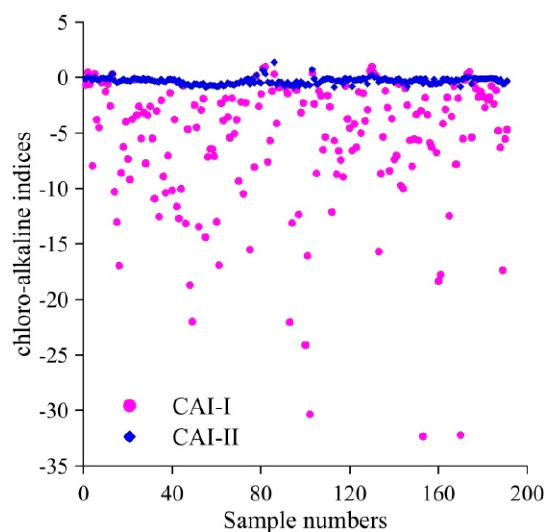
Figure 4. Scatter diagram of the chloro-alkaline indices (CAI-I and CAI-II) of groundwater samples in the study region.